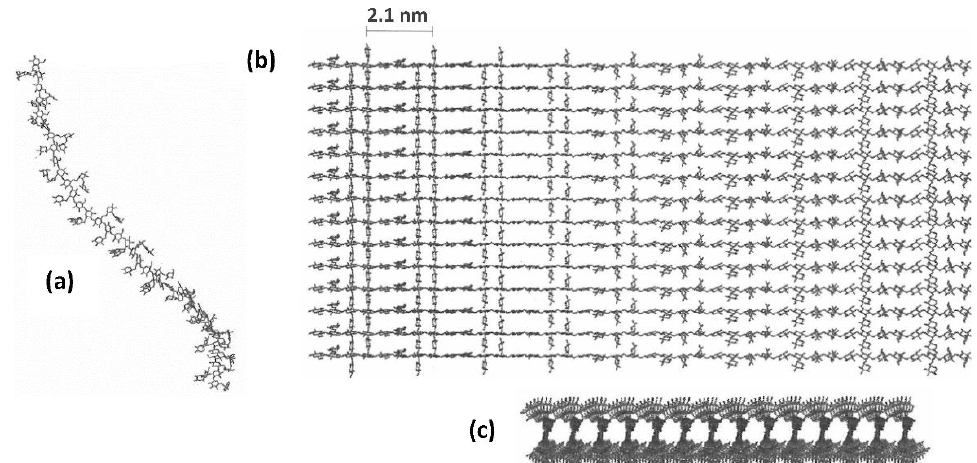
Figure 2. ( a ) Flat-ribbon morphology of a single XG chain in aqueous solution; ( b ) flat lateral self- aggregates of XG chains, simulated by Urakawa et al.; and ( c ) cross-section of flat self-aggregates. (Reproduced from Reference [31], with permission from Trends in Glycoscience and Glycotechnol- ogy.)